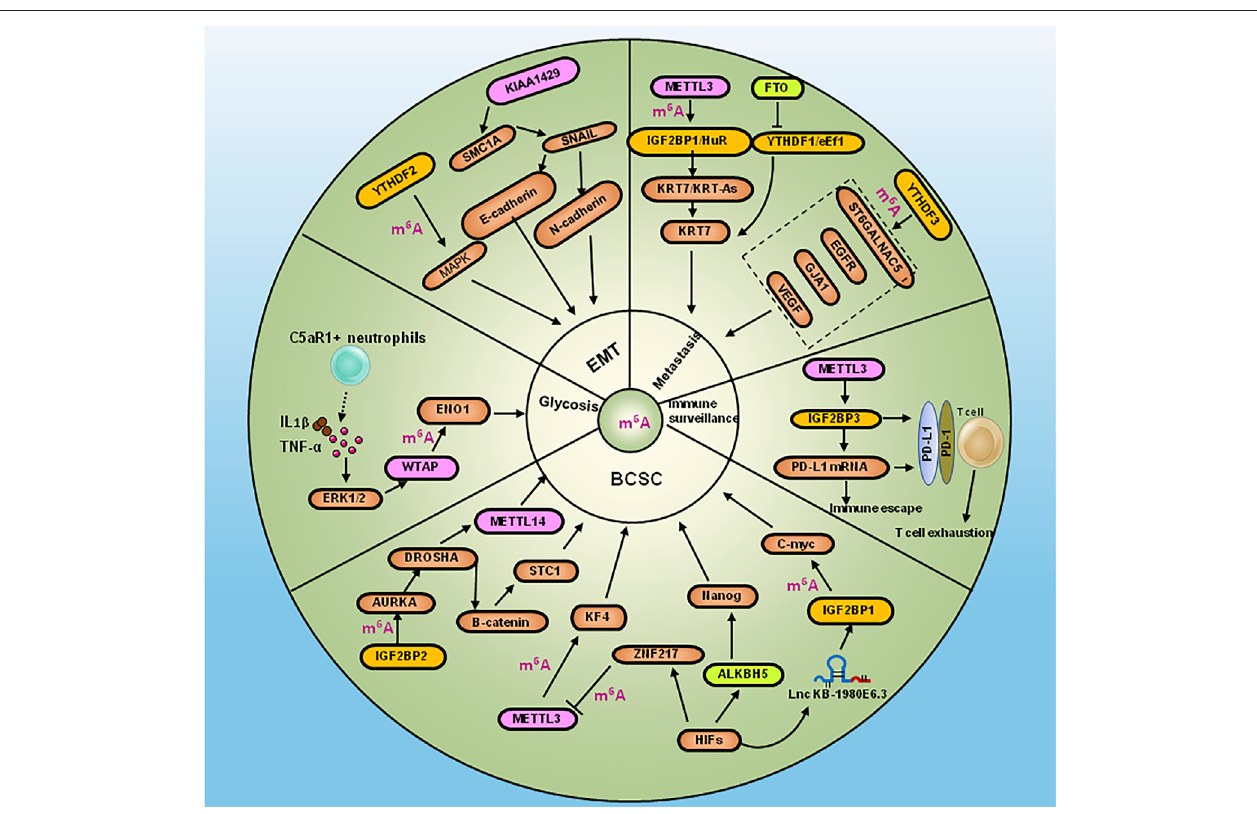
FIGURE 2 | Diagram summarizing RNA modi fi cation regulators in the pathogensis of BCSC, metastasis, EMT, glycosis and immune escape of breast caner. BCSC:BindingofAURKA toDROSHAtranscripts inducedbyIGF2BP2toenhanceBCSCstemness,meanwhile DROSHAinteracted with β -catenintocontribute tothe BCSC property by activating STC1. ALKBH5 or ZNF21 increased Nanog and KLF4 mRNA expression by m 6 A methylation, which led to pluripotency of breast cancer under hypoxic condition. The Lnc RNA KB-1980E6.3 facilitated BCSC self-renewal by IGF2BP1/c-Myc axis under hypoxic condition. Metastasis:YTHDF3 enhancedtranslationofST6GALNAC5,GJA1,EGFRandVEFGtopromotebreastcancermetastasistothebrain.METTL3andFTOpromotedlungmetastasisofbreast cancer by KRT7 via suppressing YTHDF1/eEf1 complex and increasing IGF2BP1/HuR complex. EMT: YTHDF2 induced EMT by activating MAPK pathway. KIAA1429 promoted EMT by SMC1A/SNAIL in breast cancer. Glysosis: C5aR1-positive neutrophils secreted IL-1 β and TNF α to synergistically activate ERK1/2, which resulted in the stabilizing WTAP to affect the glycolysis of breast cancer via ENO1. Immune surveillance: METTL3 upregulate PD-L1 via IGF2BP3 by m 6 A-dependent manner to modulate immune escape and T cell exhausition in breast